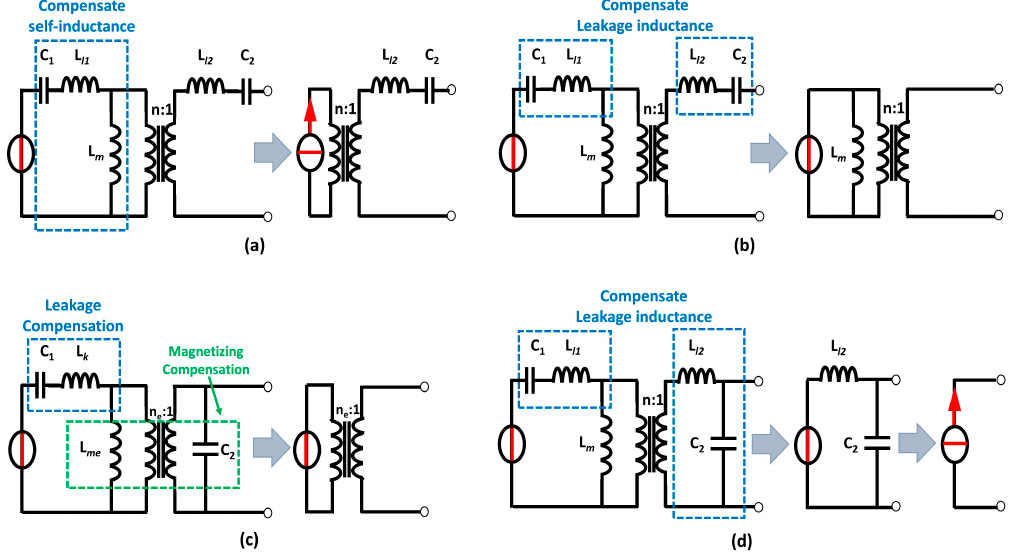
Figure 17. Single-element IPT compensation schemes: ( a ) self-inductance-compensated SS; ( b ) leakage inductance-compensated SS; ( c ) hybrid-compensated SP, and ( d ) leakage inductance-compensated SP [16].